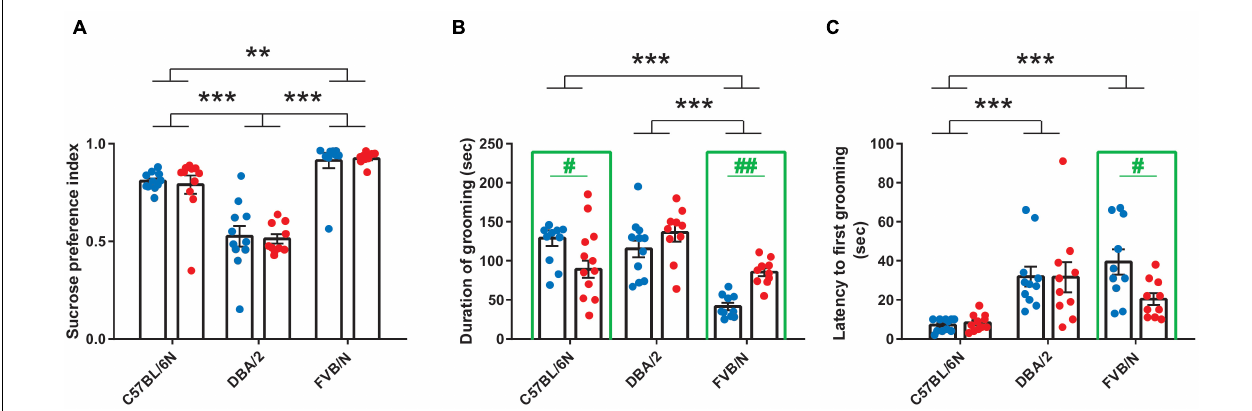
FIGURE 2 | Baseline anhedonia- and apathy-like behaviors in adult C57BL/6N, DBA/2 and FVB/N mice. (A) In the sucrose preference test, adult DBA/2 mice showed increased baseline anhedonia-like behaviors by having a lower sucrose preference index than C57BL/6N and FVB/N mice. Additionally, FVB/N mice showed a higher sucrose preference index than C57BL/6N mice. (B) The splash test revealed a decreased grooming duration in FVB/N compared to C57BL/6N and DBA/2 mice. (C) C57BL/6N mice exhibited a decreased latency to first grooming in the splash test compared to DBA/2 and FVB/N mice. In panel (A) , no sex difference was revealed in the sucrose preference test within any of the aforementioned strains. In panel (B) , male FVB/N mice showed a decreased duration of grooming, while male C57BL/6N mice showed an increase in the duration of grooming compared to their female littermates. In panel (C) , male FVB/N mice showed an increased latency to first grooming compared to their female littermates. Blue and red dots represent males and females, respectively. Two-way ANOVA was used followed by the Tukey’s post-hoc test for multiple comparisons to determine differences between the three strains C57BL/6N, DBA/2, and FVB/N (** p ≤ 0.01, *** p ≤ 0.001) and Bonferroni correction to check differences between males and females within each strain (in green: # p ≤ 0.05, ## p ≤ 0.01). A green rectangle indicates a significant difference between sexes within a strain. Error bars indicate the standard error of the mean